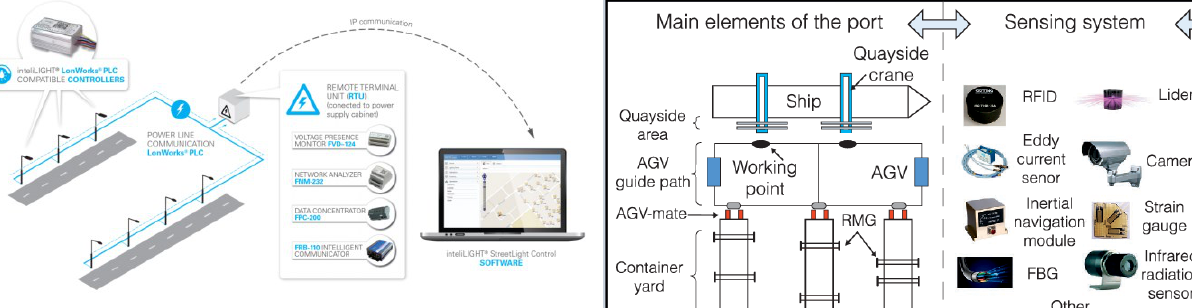
Figure 5 . Smart street /field lighting using PLC- applicable also for port environments [11]. Figure 6 . Assets and sensors/actuators layers building the IoT